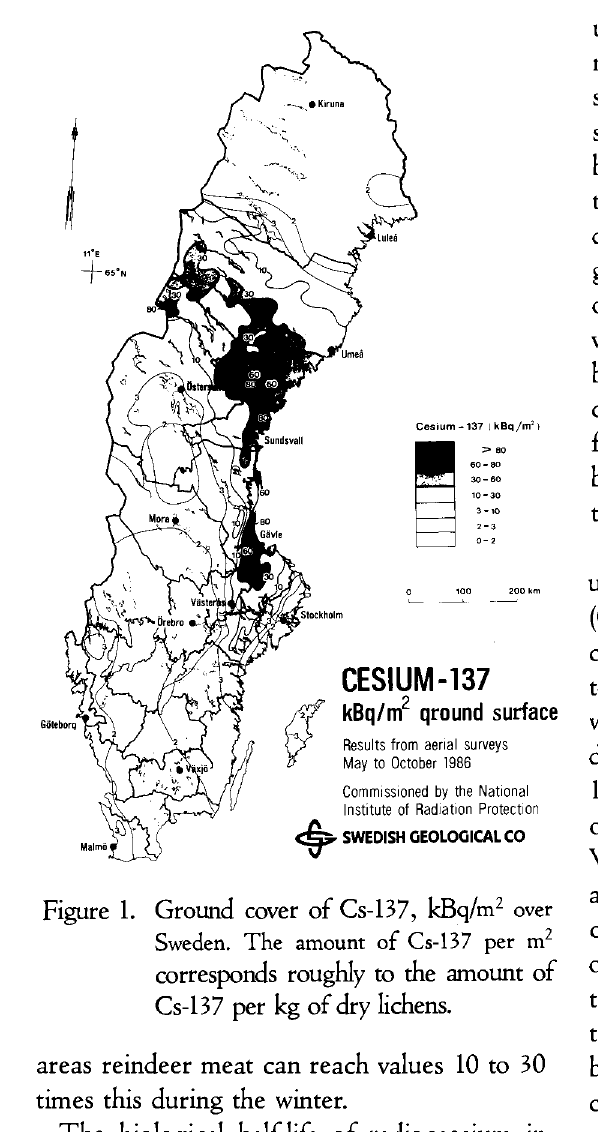
CESIUM-137 kBq/m 2 qround surface Results from aerial surveys May to October 1986 Commissioned by the National Institute of Radiation Protection SWEDISH GEOLOGICAL CO Ground cover of Cs-137, kBq/m 2 over Figure 1. Sweden. The amount of Cs-137 per m 2 corresponds roughly to the amount of Cs-137 per kg of dry